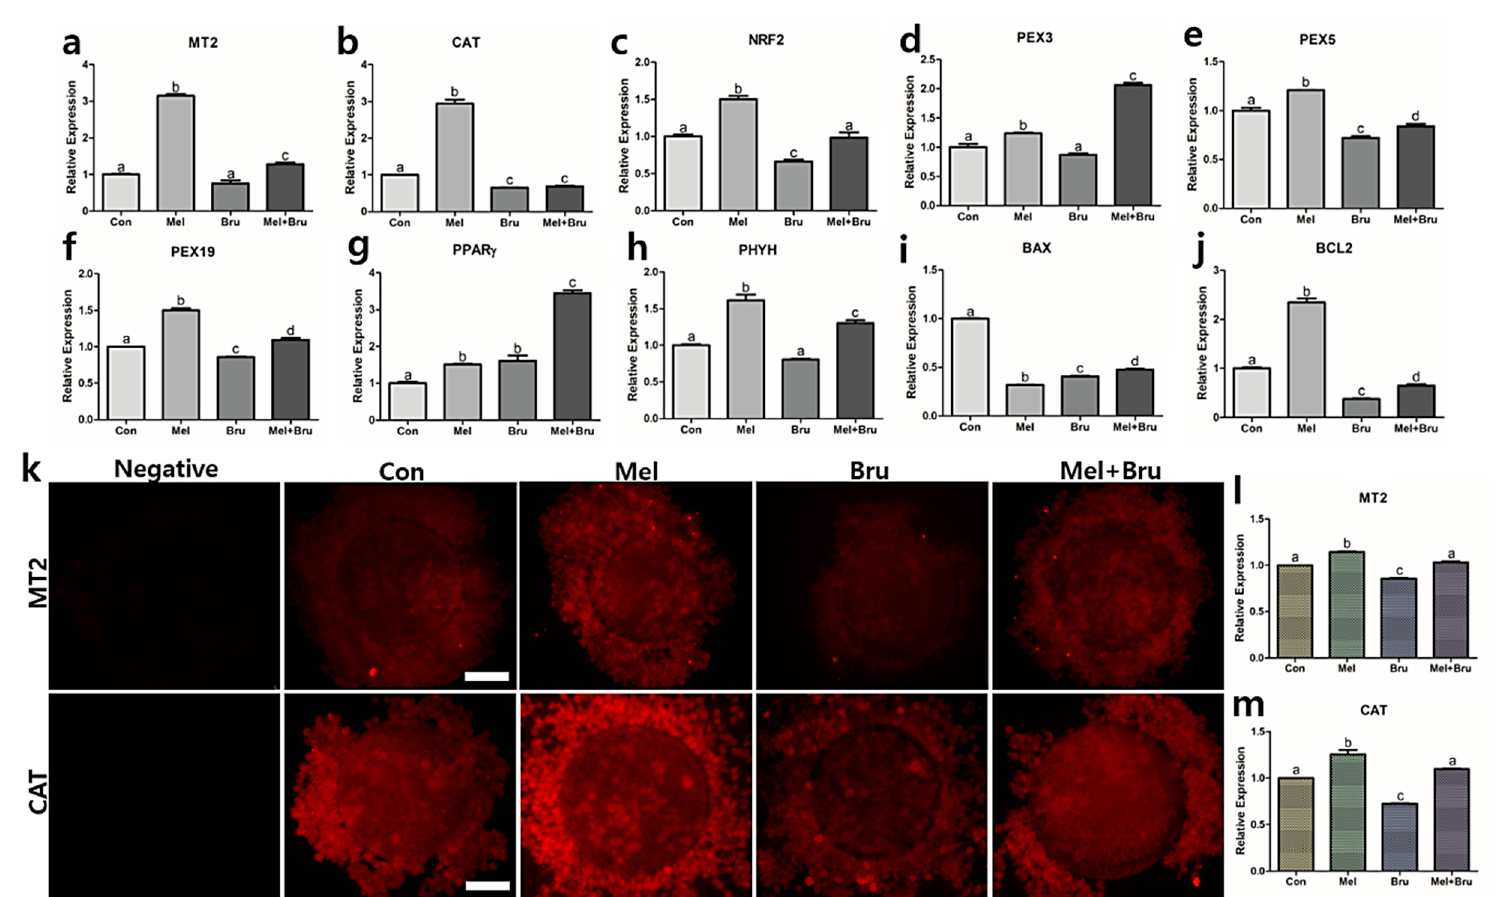
Figure 6. Assessments of genes of interest by qRT-PCR and protein expression analysis by immunocytochemistry in porcine COCs. ( a ) Gene expressions related to ( a , b ) melatonin and antioxidant ( MT2 and CATALASE ), ( c ) Nrf2 signaling ( NRF2 ), ( d – h ) peroxisomal activities ( PEX3, PEX5, PEX19, PPAR γ , and PHYH ), and ( i , j ) apoptosis ( BAX and BCL2 ) were tested. ( k – m ) The protein expression of MT2 and CATALASE in porcine COCs were evaluated by immunocytochemistry. Bars with letters indicate significant di ff erences ( p < 0.05). Original magnification: 400 × , bars indicate 30 µ m Con; control, Mel; melatonin, Bru; brusatol, and Mel + Bru; melatonin + brusatol. At least three technical and biological replicates were performed.